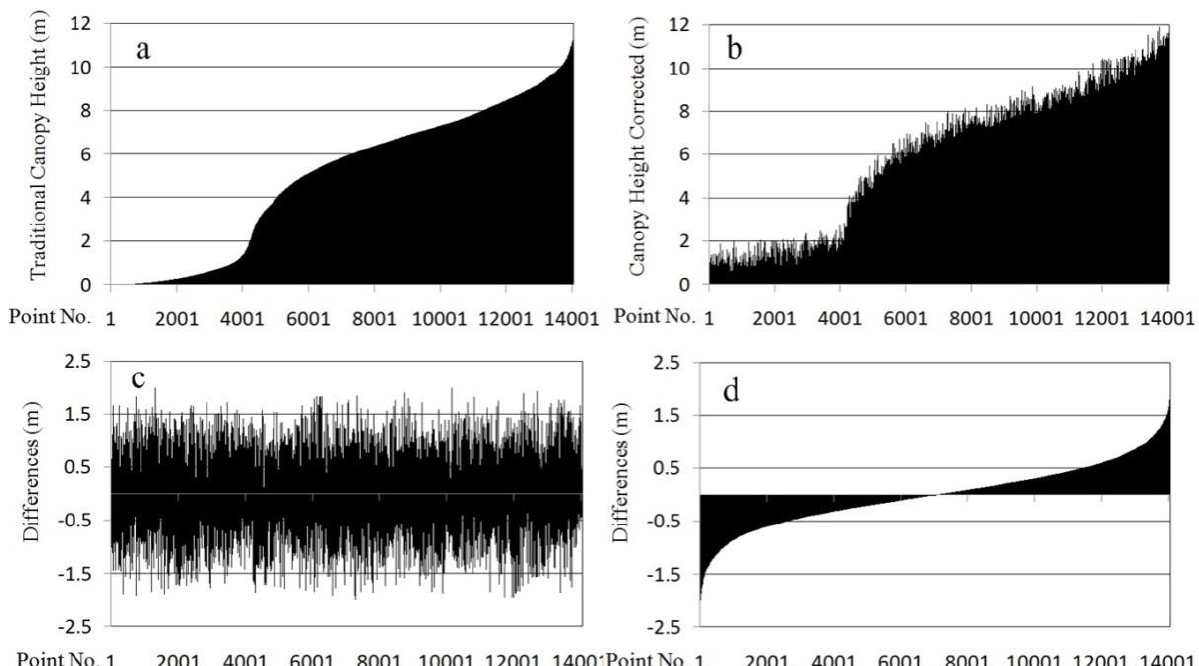
Figure 9. Canopy height before and after correction and canopy height differences in plot No. 34: ( a ) canopy height before correction; ( b ) canopy height after correction; ( c ) canopy height differences before and after correction; ( d ) canopy height differences in ascending